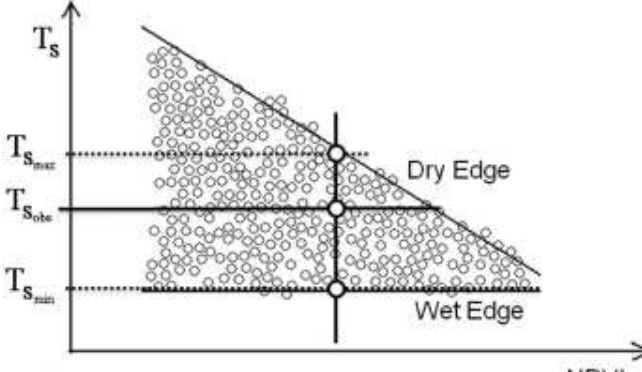
Figure 2. A simplified presentation of TVDI adapted from Sandholt et al. (2002).